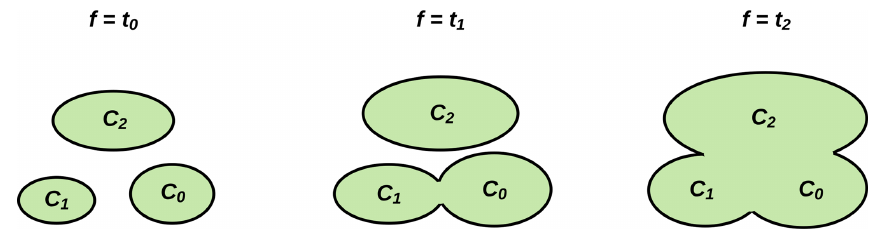
Figure 4. An illustration of the connected regions in the superlevel set (defined in Eq. 2) that are split into three pieces at value t 0 . They grow and merge first at value t 1 and then at t 2 when values of function f are systematically decreasing.